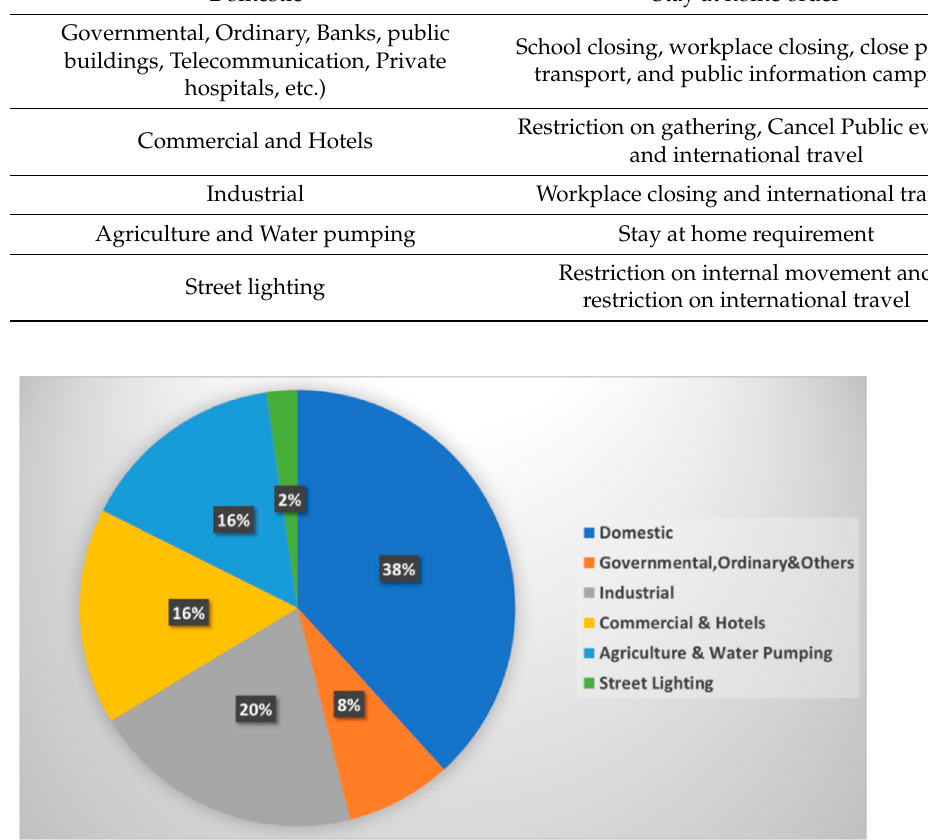
Figure 1. Electricity consumption by sector in Jordan